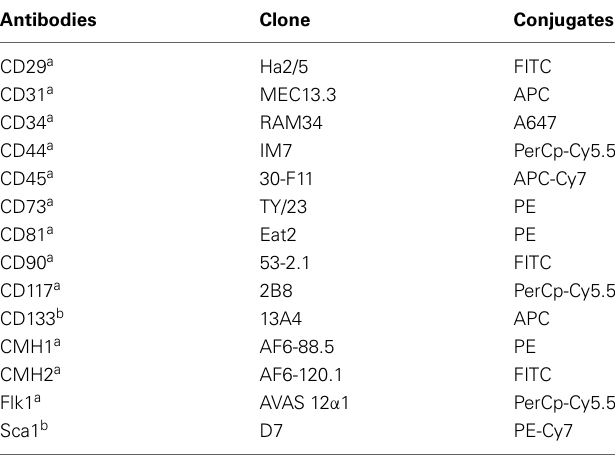
Table 1 | List of conjugated monoclonal antibodies used for cell